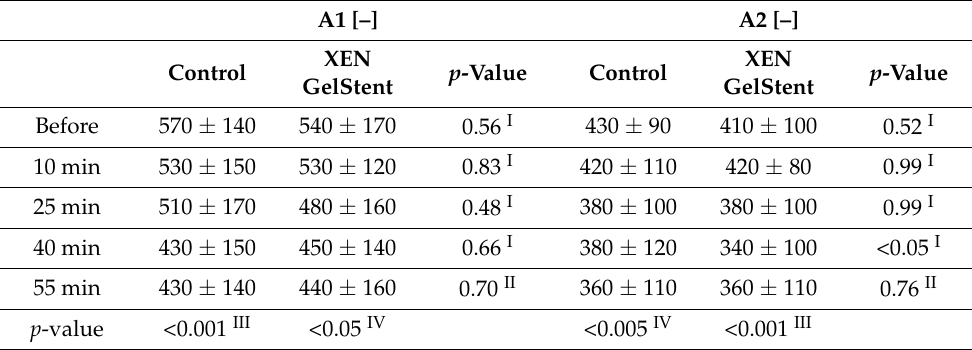
Table 4. Amplitudes of the first and second applanation (respectively A1 and A2) during the water drinking test (WDT) in the control and XEN GelStent groups. A1 [–] A2 [–] XEN XEN p -Value p -Value Control Control GelStent GelStent Before 570 ± 140 540 ± 170